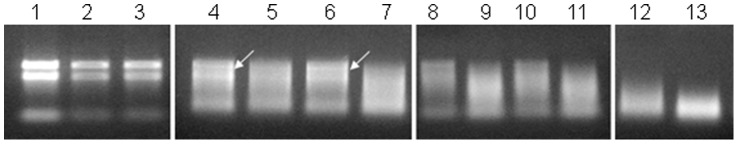
Ribonuclease activity of recombinant TcPR-10 Wild Types (wt) and Mutant visualized in 1% agarose gel. 1 µg RNA from M. perniciosa was incubated with 1 µg of recombinats proteins at 25°C at different times.Lane 1. RNA without protein; Lane 2. RNA with boiled TcPR10 mut 2 h incubation; Lane 3. RNA with boiled TcPR10 wt 2 h incubation; Lane 4, 6, 8, 10 and 12 RNA incubated with TcPR10 mut by 10 min, 20 min, 1 h, 2 h and 3 h, respectively; Lane 5, 7, 9, 11 and 13 RNA incubated with TcPR10 wt by 10 min 20 min, 1 h, 2 h and 3 h, respectively. Arrows indicate RNA bands without degradation.